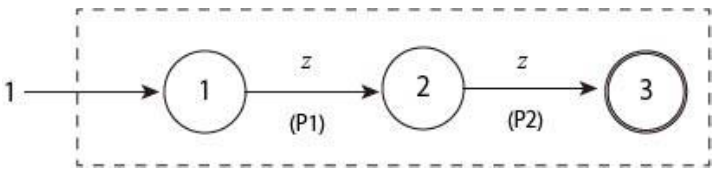
Figure 2. Phase structure for equation